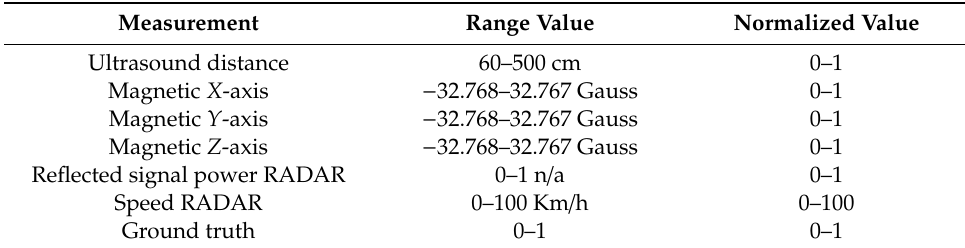
Table 1. Sensor measurement ranges and corresponding